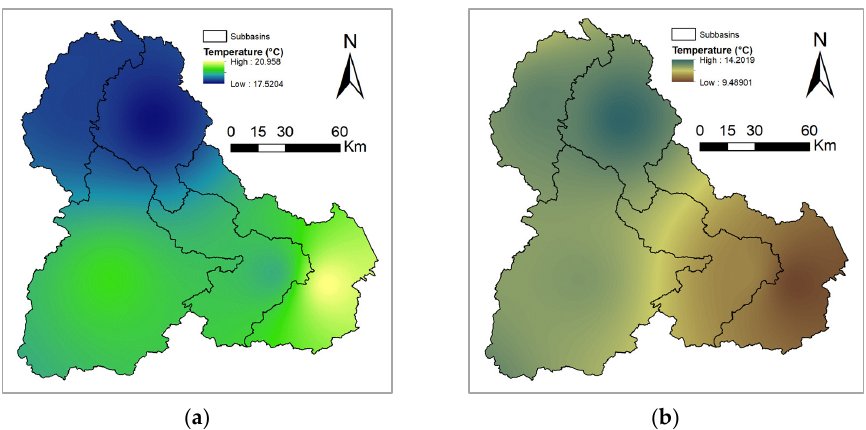
Figure A1. Spatial distribution of annual ( a ) maximum temperature (°C) and ( b ) temperature range (°C).